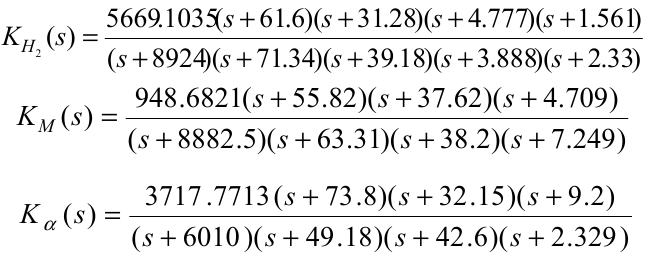
Figure 6. Singular value curves of sensitivity function S and 1 −